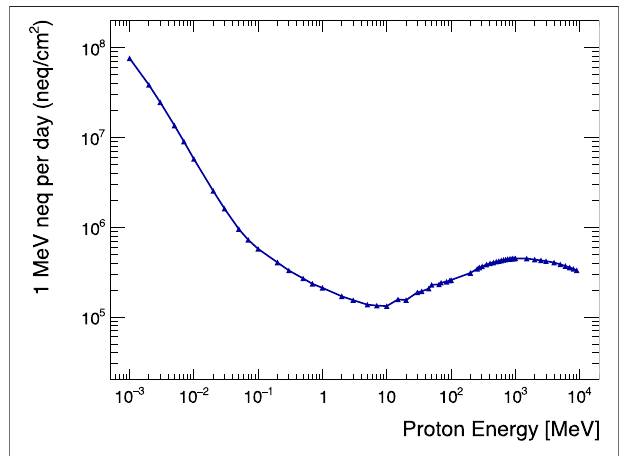
FIGURE 3 | Average daily proton fl uence, in 1-MeV-neutron equivalent per area, as a function of proton kinetic energy.